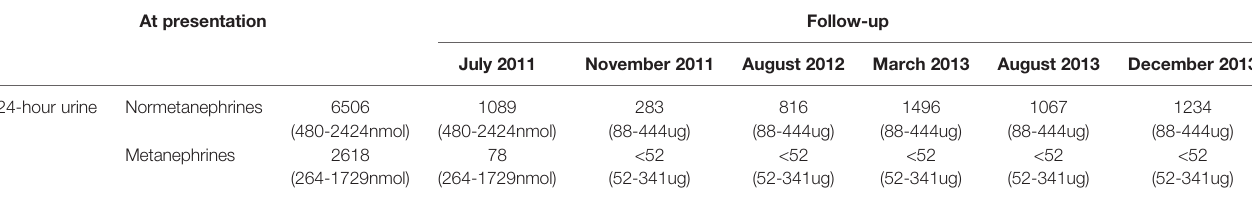
TABLE 1 | Urinary catecholamines and metanephrines (reference range) at presentation and during follow-up of Patient 1. At